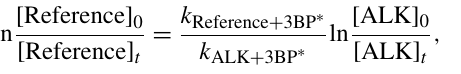
Scheme 1. Thermodynamic cycle used to calculate bond dissocia- tion free energies.